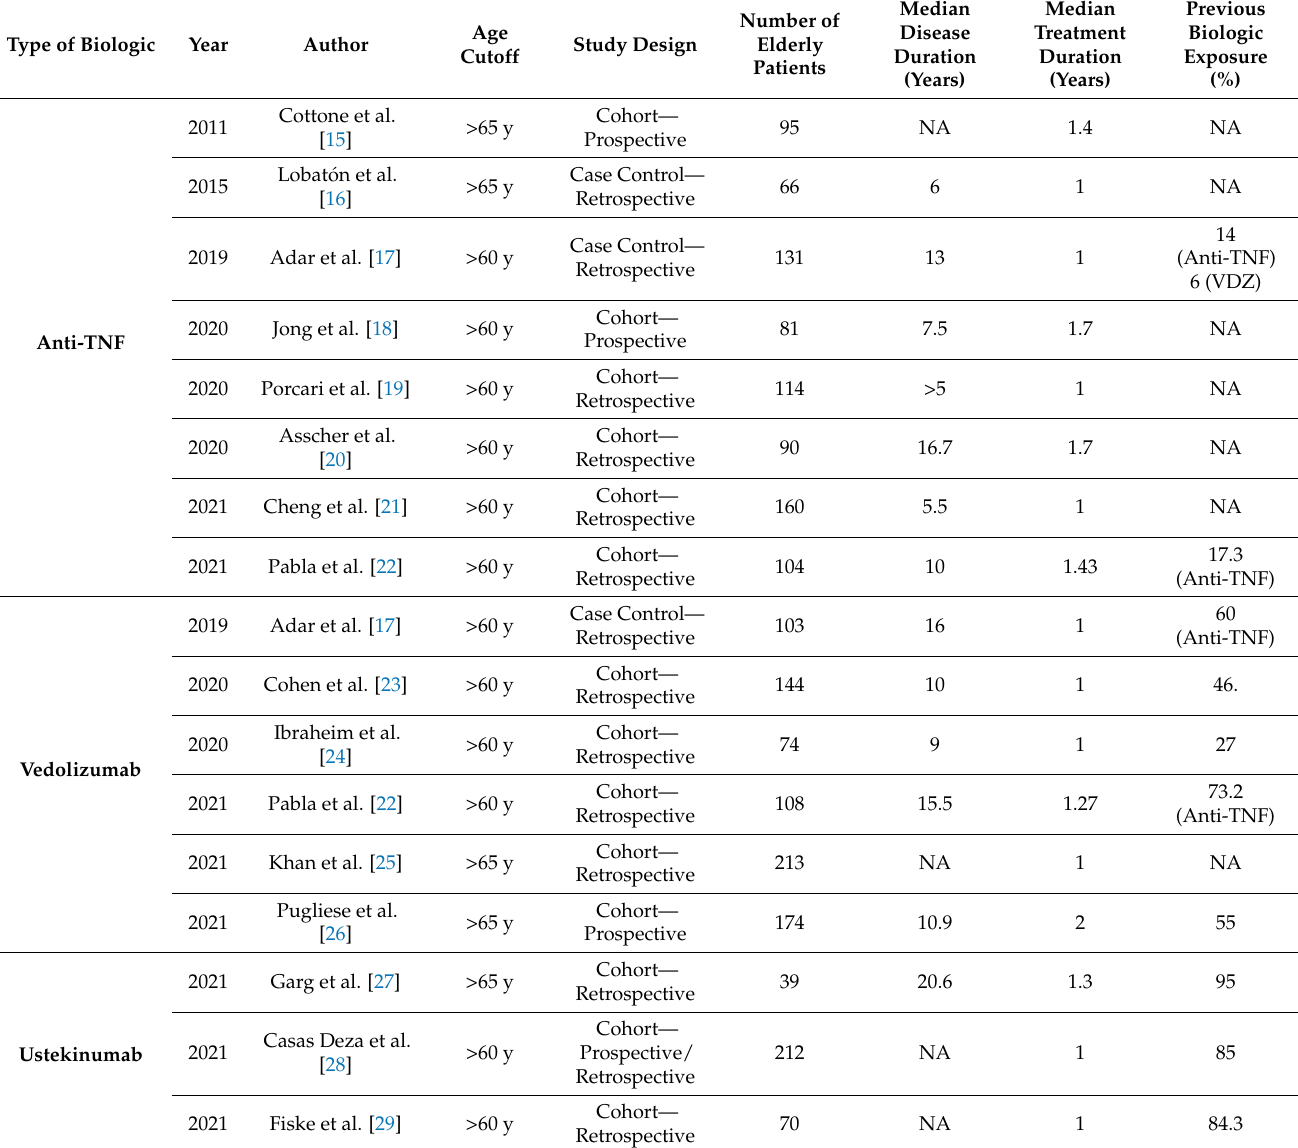
Table 1. Characteristics of studies included in the systematic review and